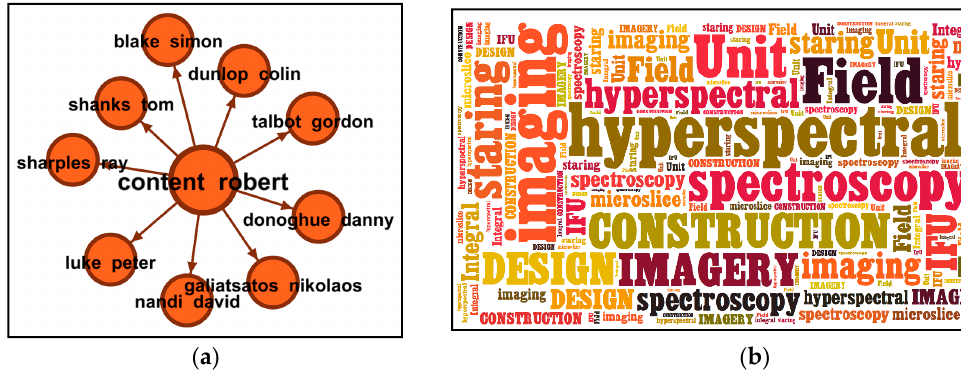
Figure 9. Content, R. research community ( a ) and related topics ( b ).